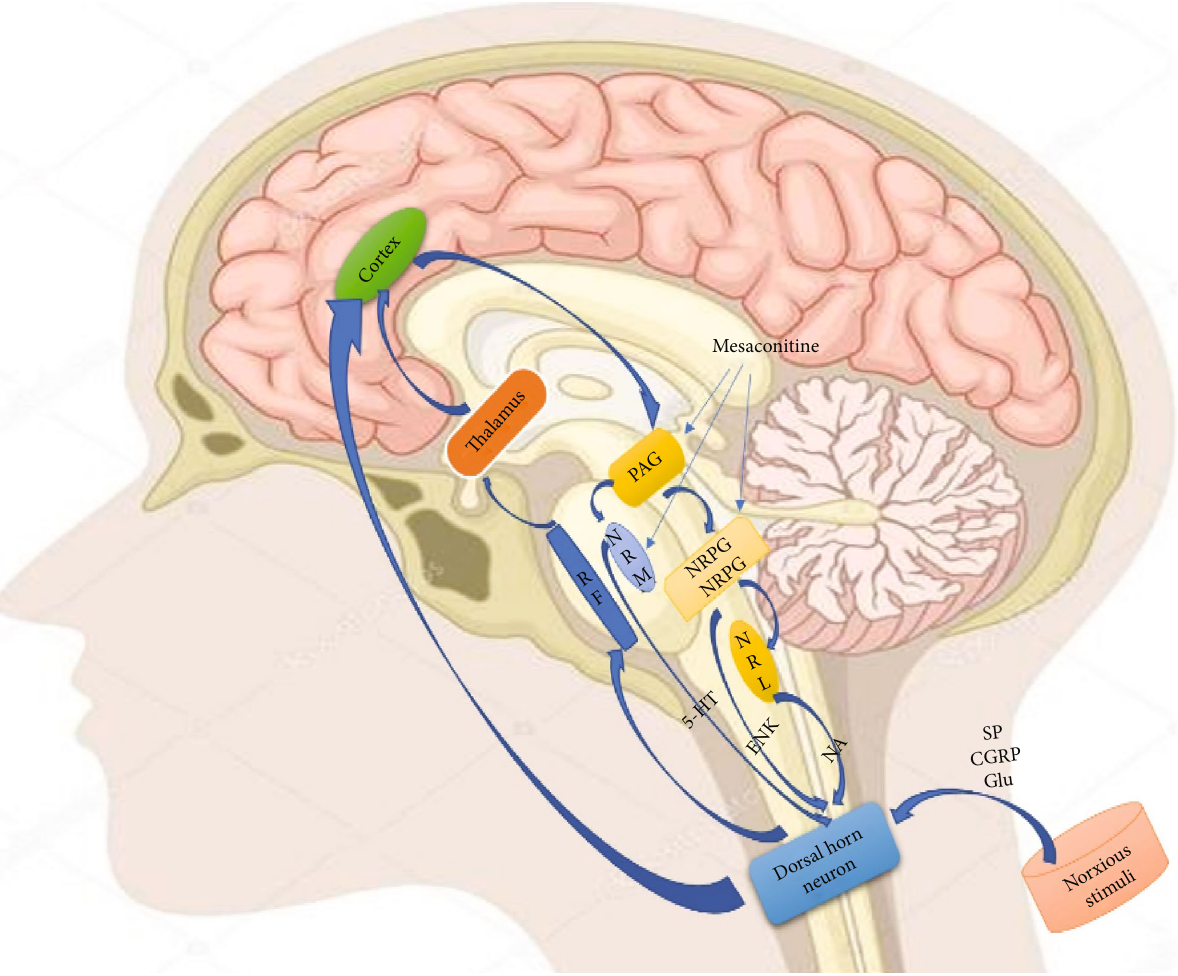
Figure 2: Schematic drawing of the nociceptive system with ascending and descending fi bers. RF: reticular formation; PAG: periaqueductal gray; NRM: nucleus raphe magnus; NRGC: nucleus reticularis gigantocellularis; NRPG: nucleus reticularis paragigantocellularis; NRL: nucleus reticularis lateralis; 5-HT: 5-hydroxytryptamine; ENK: enkephalin; NA: